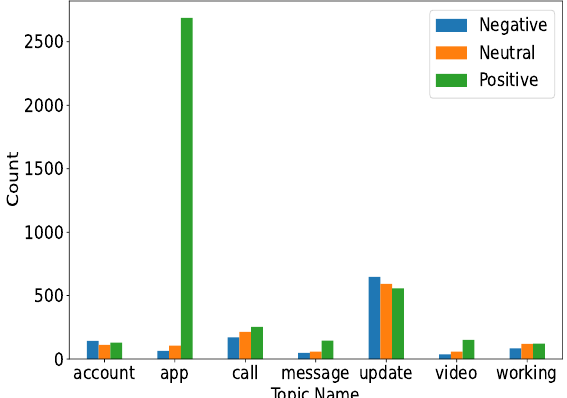
Figure 9. Sentiments regarding the IMO app.